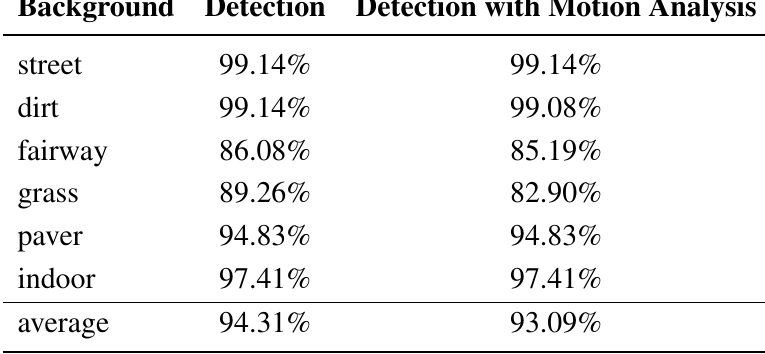
Table 7. Mean value of the correct first detection for different